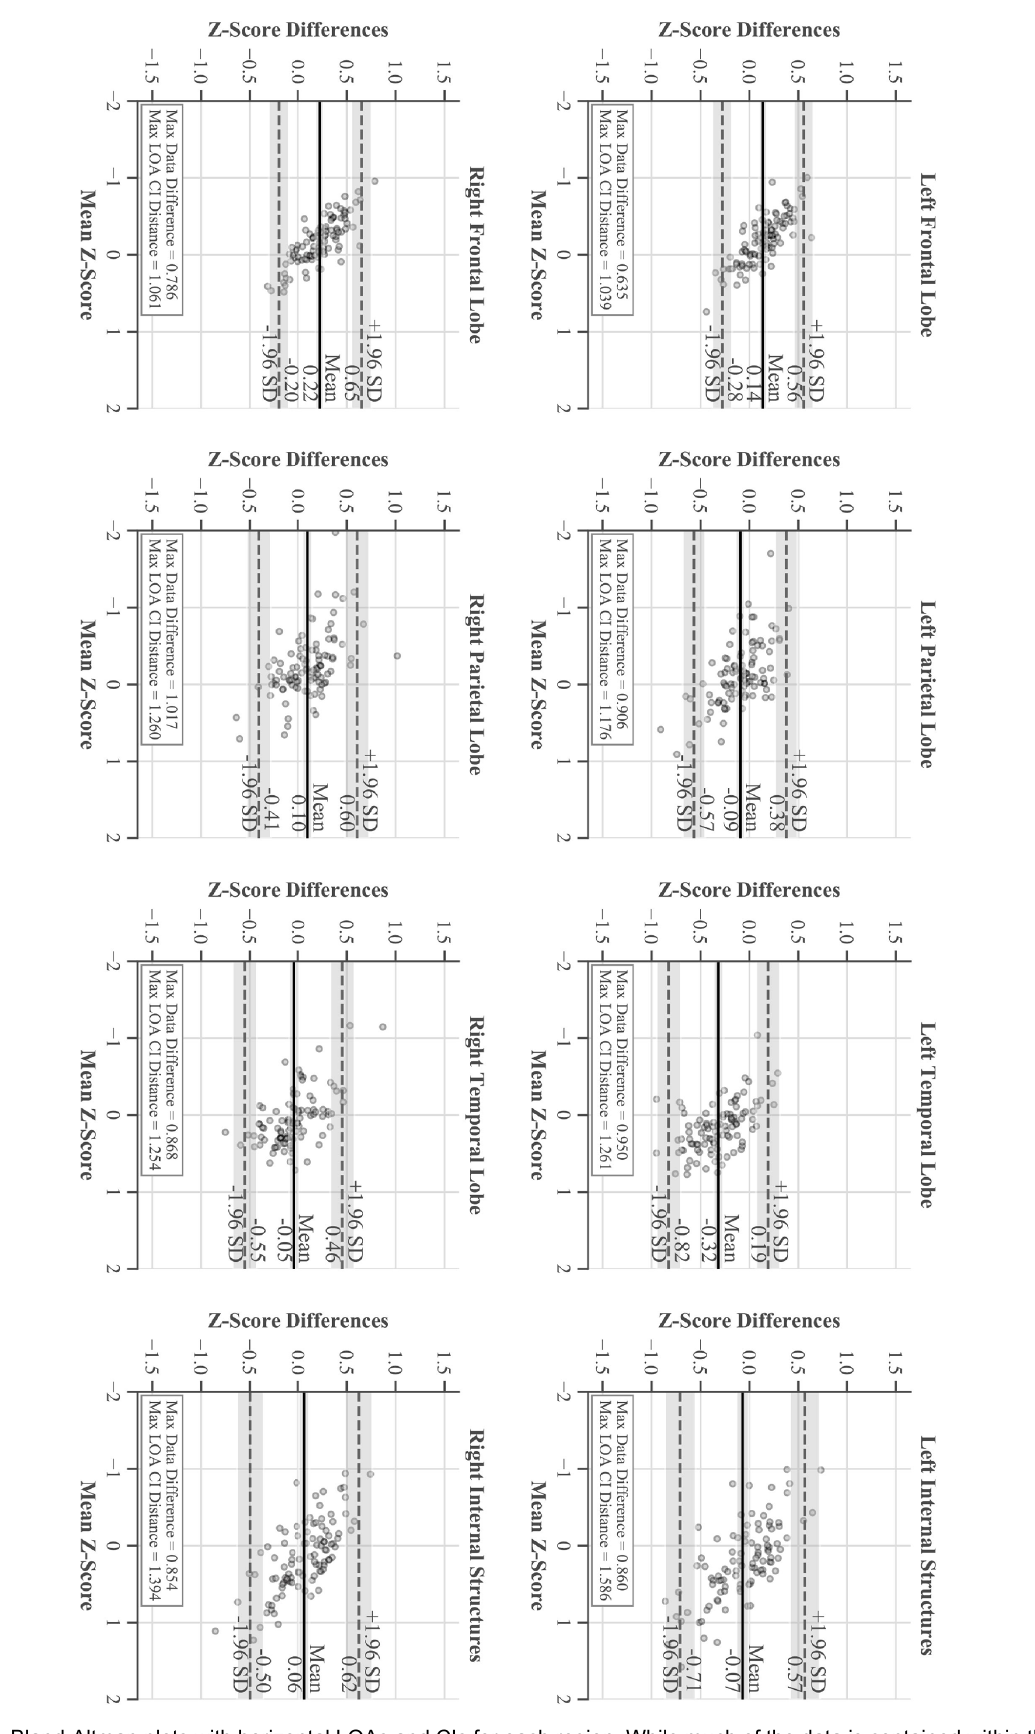
Figure 7. Bland-Altman plots with horizontal LOAs and CIs for each region. While much of the data is contained within the LOAs, proportional bias is